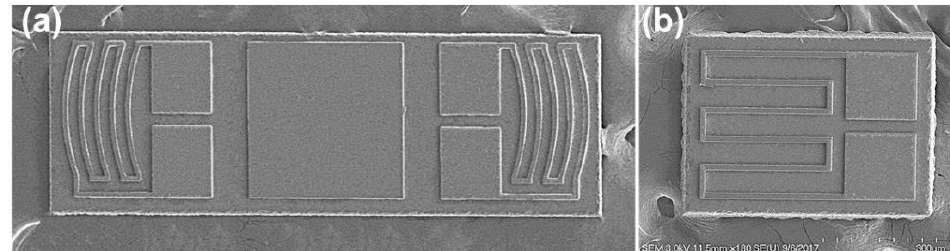
Figure 8. SEM images of the fabricated strain gauges: ( a ) dual-arc strain gauge (two tangential gauges) and ( b ) single linear (radial) gauge.